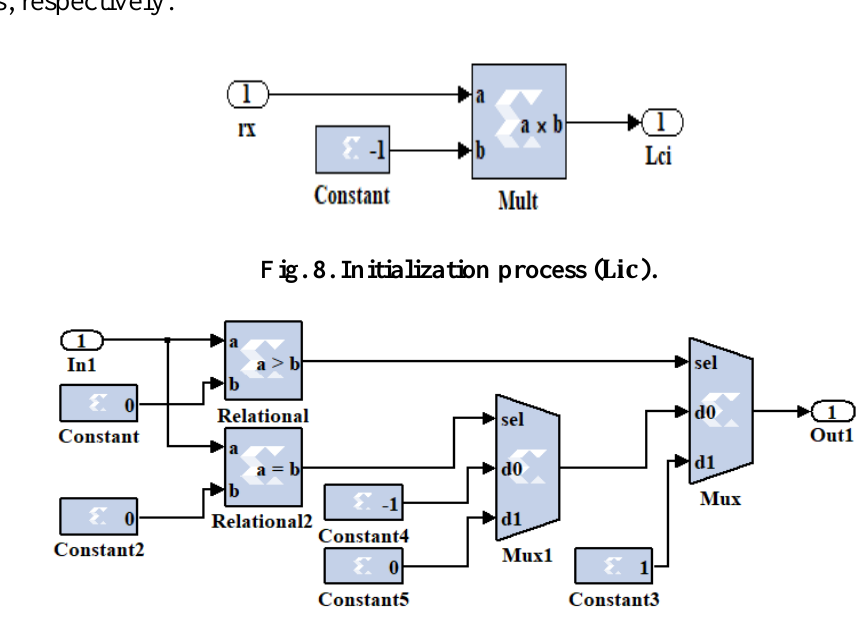
Fig. 9. Sign block details.